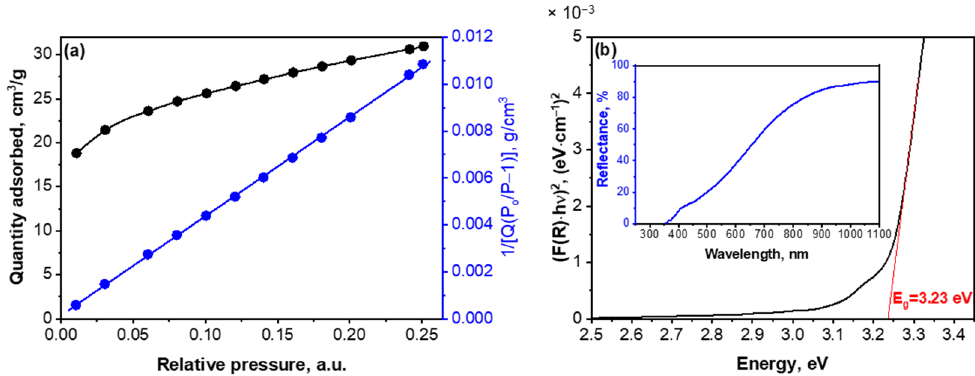
Figure 6. ( a ) Low-temperature nitrogen adsorption isotherms of the r -TiO 2 spherulites. ( b ) Tauc plot, Figure 6. ( a ) Low ‐ temperature nitrogen adsorption isotherms of the r ‐ TiO 2 spherulites. ( b ) Tauc plot, insert: diffuse reflectance spectrum. insert: diffuse reflectance